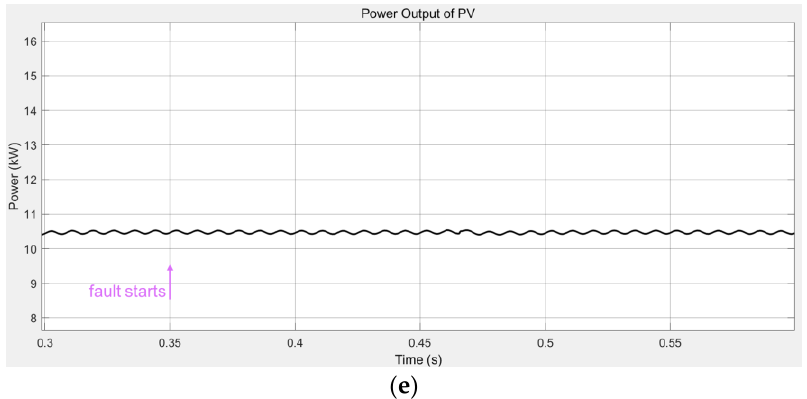
Figure 11. Performance when a line disconnection fault occurs on the DC side. ( a ) Signals at Bus 6; ( b ) Signals at AC/DC interfacing Bus 8; ( c ) Signals at DC bus; ( d ) Power output of the BESS; ( e ) Power output of the PV generation.